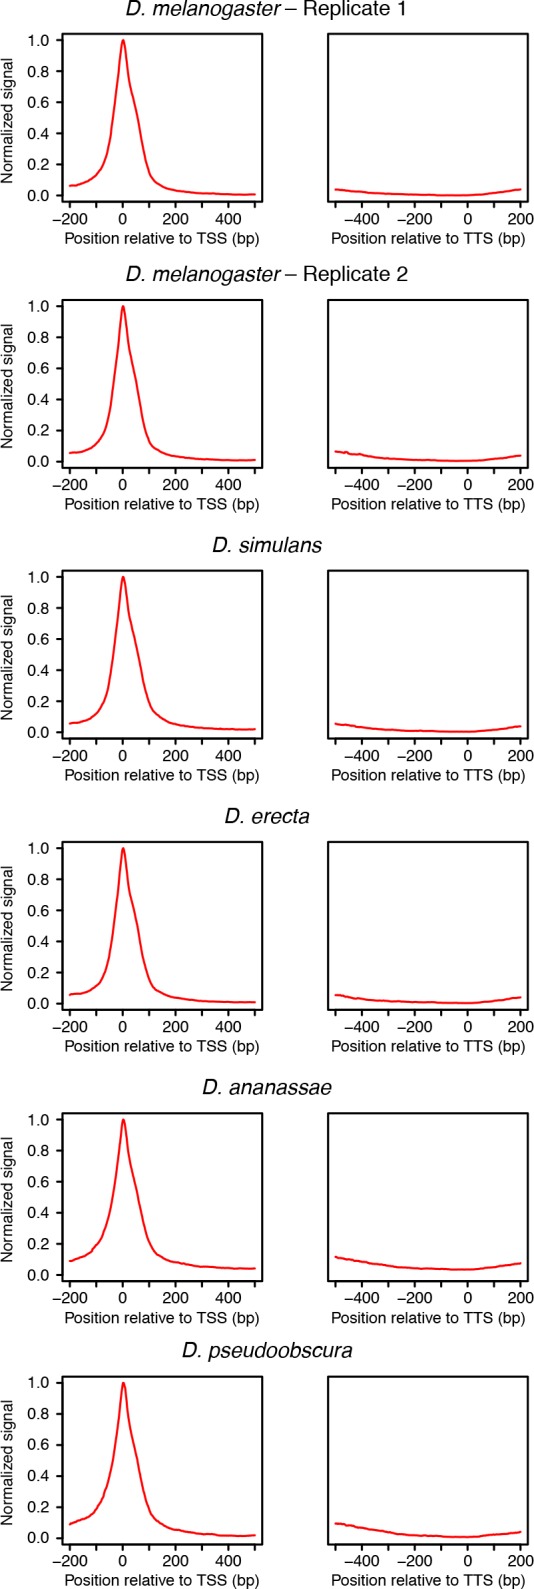
Distribution or RAMPAGE peaks over transcript annotations.For each species, RAMPAGE reads were mapped to the appropriate genome and peaks called as de- scribed in Materials and methods. The peak coordinates were then converted to orthologous D. melanogaster coordinates using chained pairwise alignments and the liftOver tool from the UCSC Genome Browser. Metagene profiles were constructed by summing signal intensity over FlyBase r5.49 mRNA annotations.